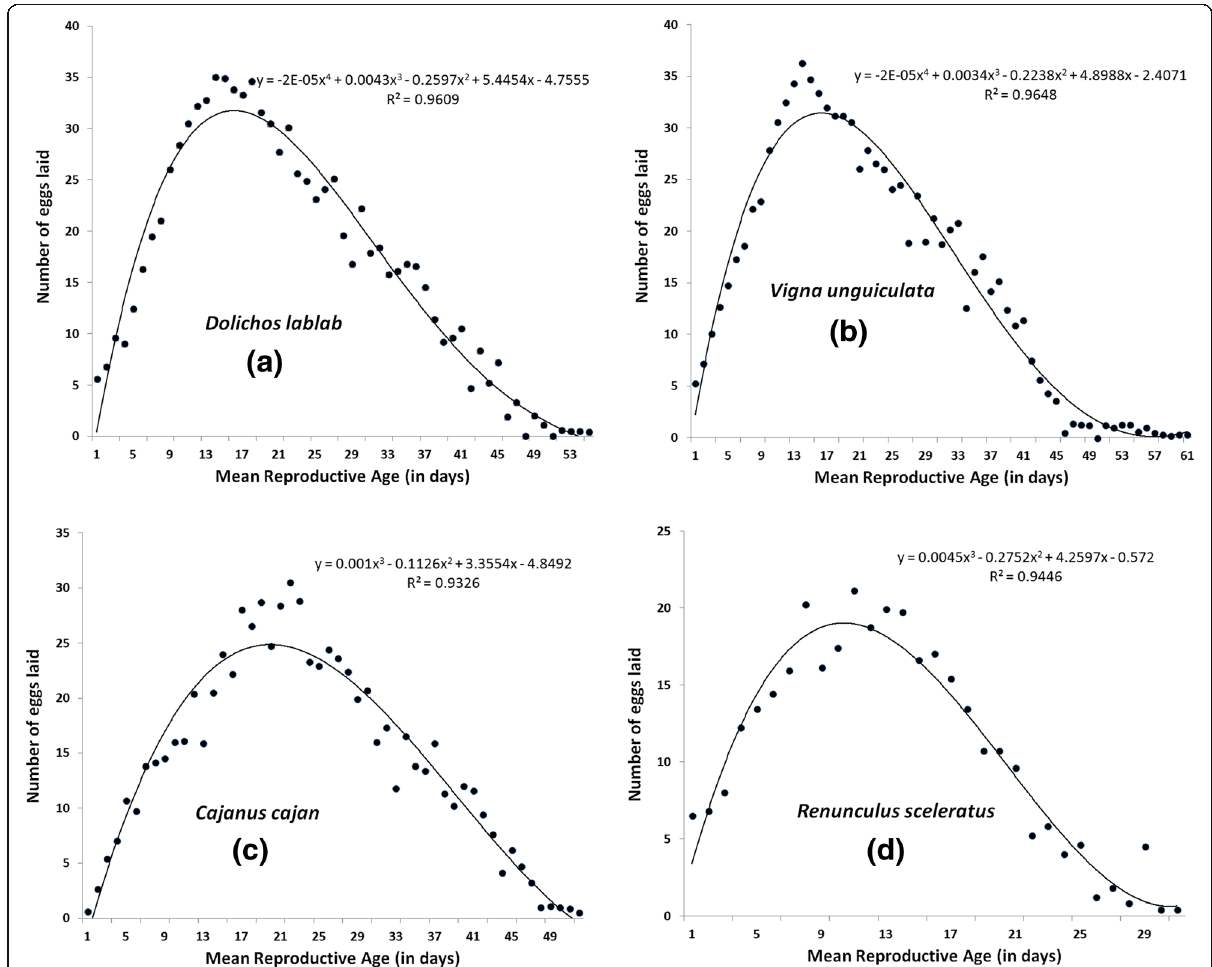
Fig. 1 Age-specific fecundity in terms of relationship between the number of eggs laid and the mean reproductive age of a ladybird, H. variegata , when fed on A. craccivora infesting a Dolichos lablab , b Vigna unguiculata , c Cajanus cajan , and d Ranunculus